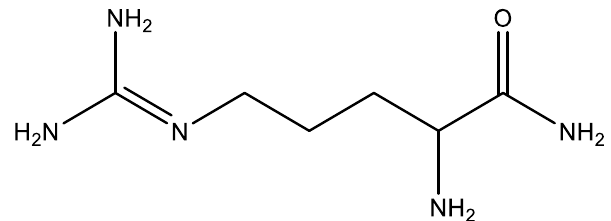
Figure 1. Molecular Structure of L-arginine (2-Amino-5-guanidinopentanoic acid) .